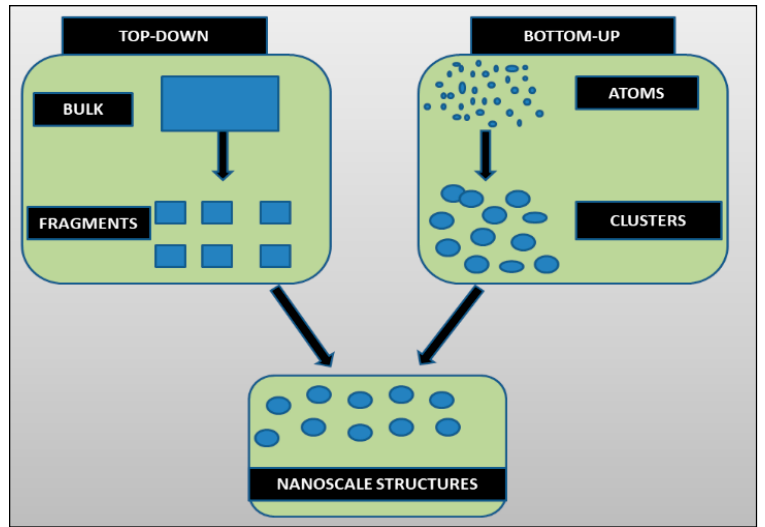
Figure 1. “Top-down” and “bottom-up” approaches for the synthesis of nanoparticles. In physical processes, the synthesis of AgNPs is achieved by evaporation–condensation method, which operates tube furnace at atmospheric pressure. AgNPs are also being produced with laser ablation of metallic bulk materials in solution. The biggest advantage of laser ablation over the conventional method is the removal of chemical reagents in solutions.